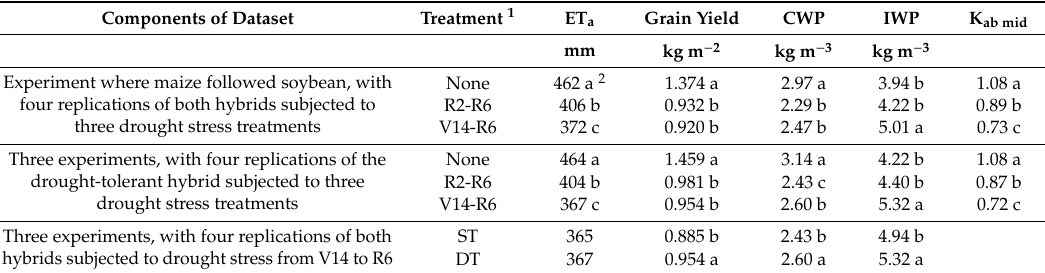
Table 4. Maize actual crop evapotranspiration (ET a ), grain yield, crop water productivity (CWP), with the optimal nitrogen rate, as influenced by the main e ff ects of drought stress treatment and hybrid.